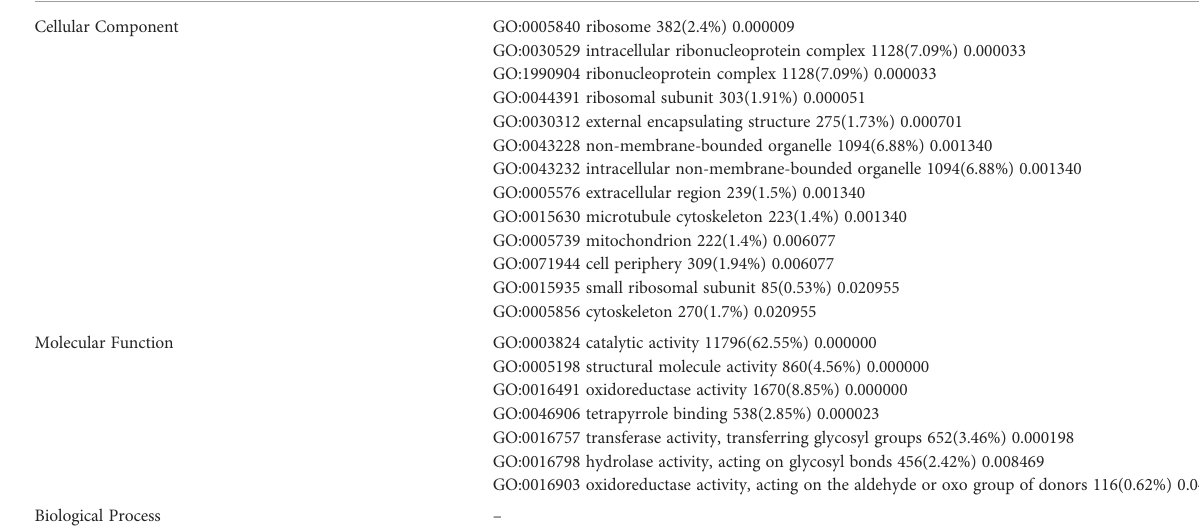
TABLE 6 Signi fi cant GO ID in all trends. GO Enrichment GO ID (description, gene ratio, Q value) Cellular